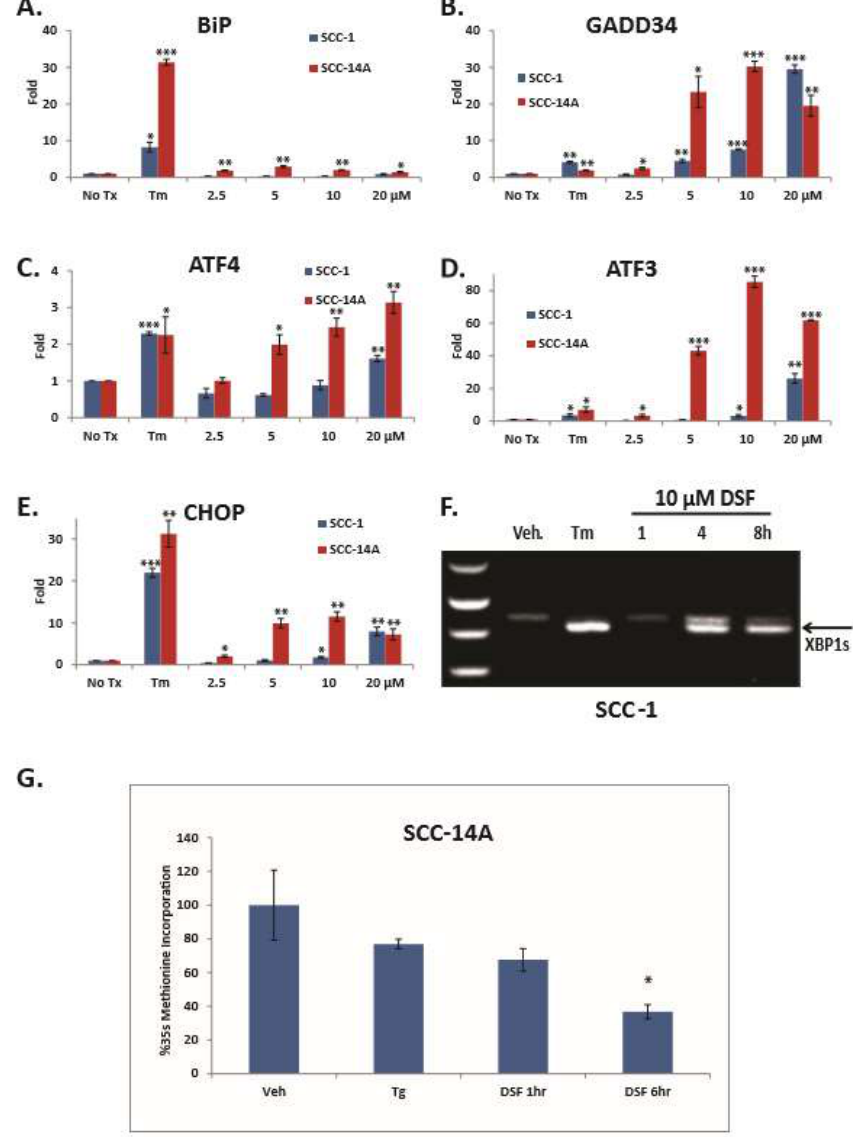
Figure 2. DSF activates unfolded response (UPR) gene expression and inhibits general protein translation. ( A – E ), RT-qPCR analysis of UPR genes; error bars represent the standard error of the mean from three experiments performed with triplicate samples. ( F ), Conventional RT-PCR to appreciate un-spliced and spliced XPB1 . ( G ), S35 pulse-labeled and TCA precipitated whole cell lysates following 10 µ M DSF treatment; error bars represent standard deviation. Two-tailed test: * p ≤ 0.05, ** p ≤ 0.01, *** p ≤